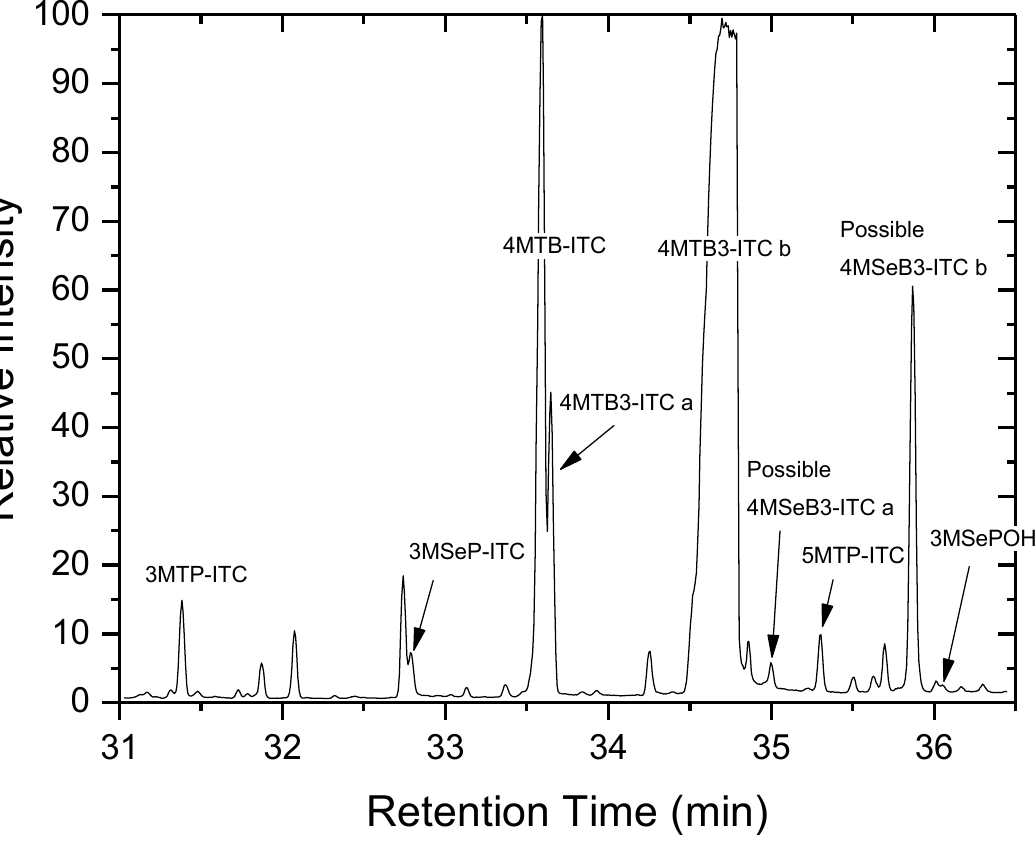
Figure 4. Total ion current Gas Chromatography-Mass Spectrometry (GC-MS) trace (on a DB-Wax capillary column) of isothiocyanate compounds identified in a diethyl ether extract of seeds harvested from Raphanus sativus plants fertilised with selenium.